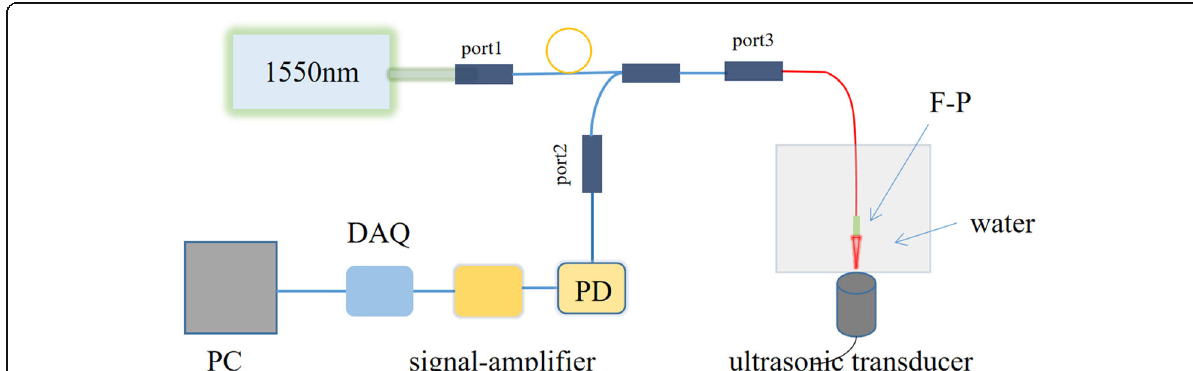
Fig. 3 Schematic diagram of the F – P mode system. The 1550 nm fiber laser is connected with toroidal port 1 through a flange device. Interface port 3 is connected with the optical fiber. The optical intensity change returned by the detection light through the F – P cavity interference of the optical fiber is received by the photoelectric detector, and the test results are obtained after amplification and acquisition processing. PD: Photoelectric detector; DAQ: Data collection card; PC: Personal